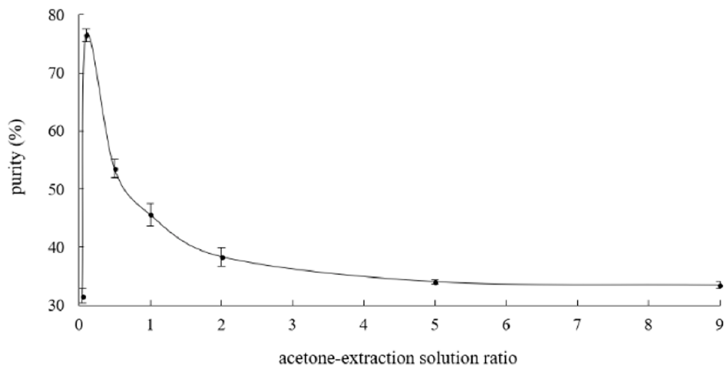
Figure 2. Effects of acetone-extraction solution ratio on purifying tea-leaf saponins by single-variable experiments.